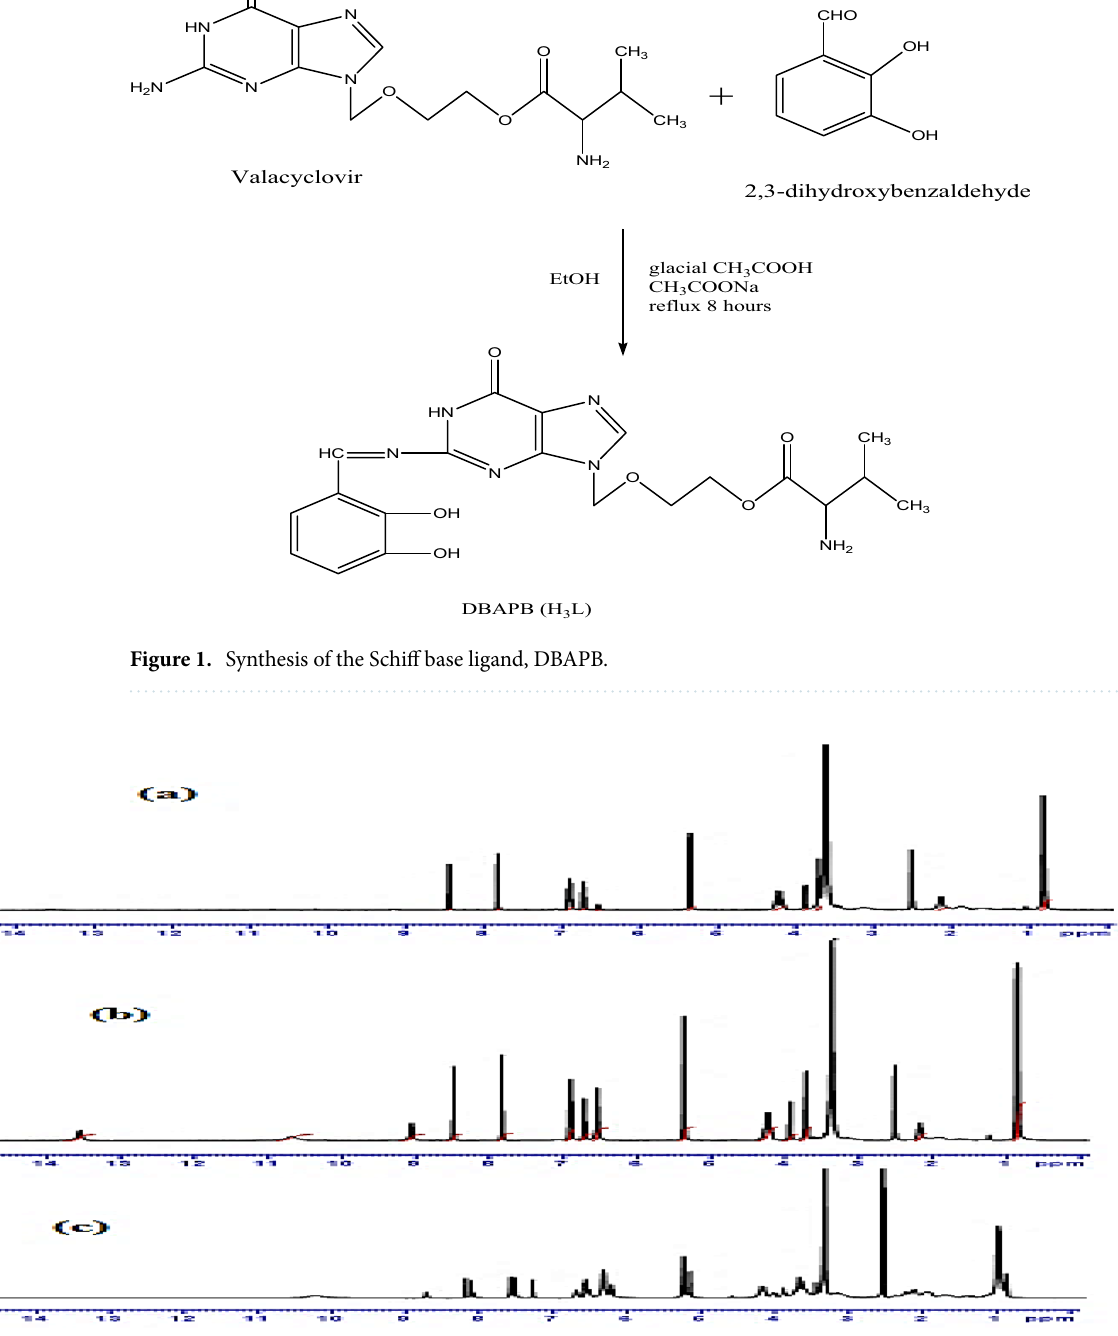
Figure 2. The 1 HNMR spectra of the ligand, DBAPB, with D 2 O ( a ), without D 2 O ( b ), and Zn(II) complex 6 ( c